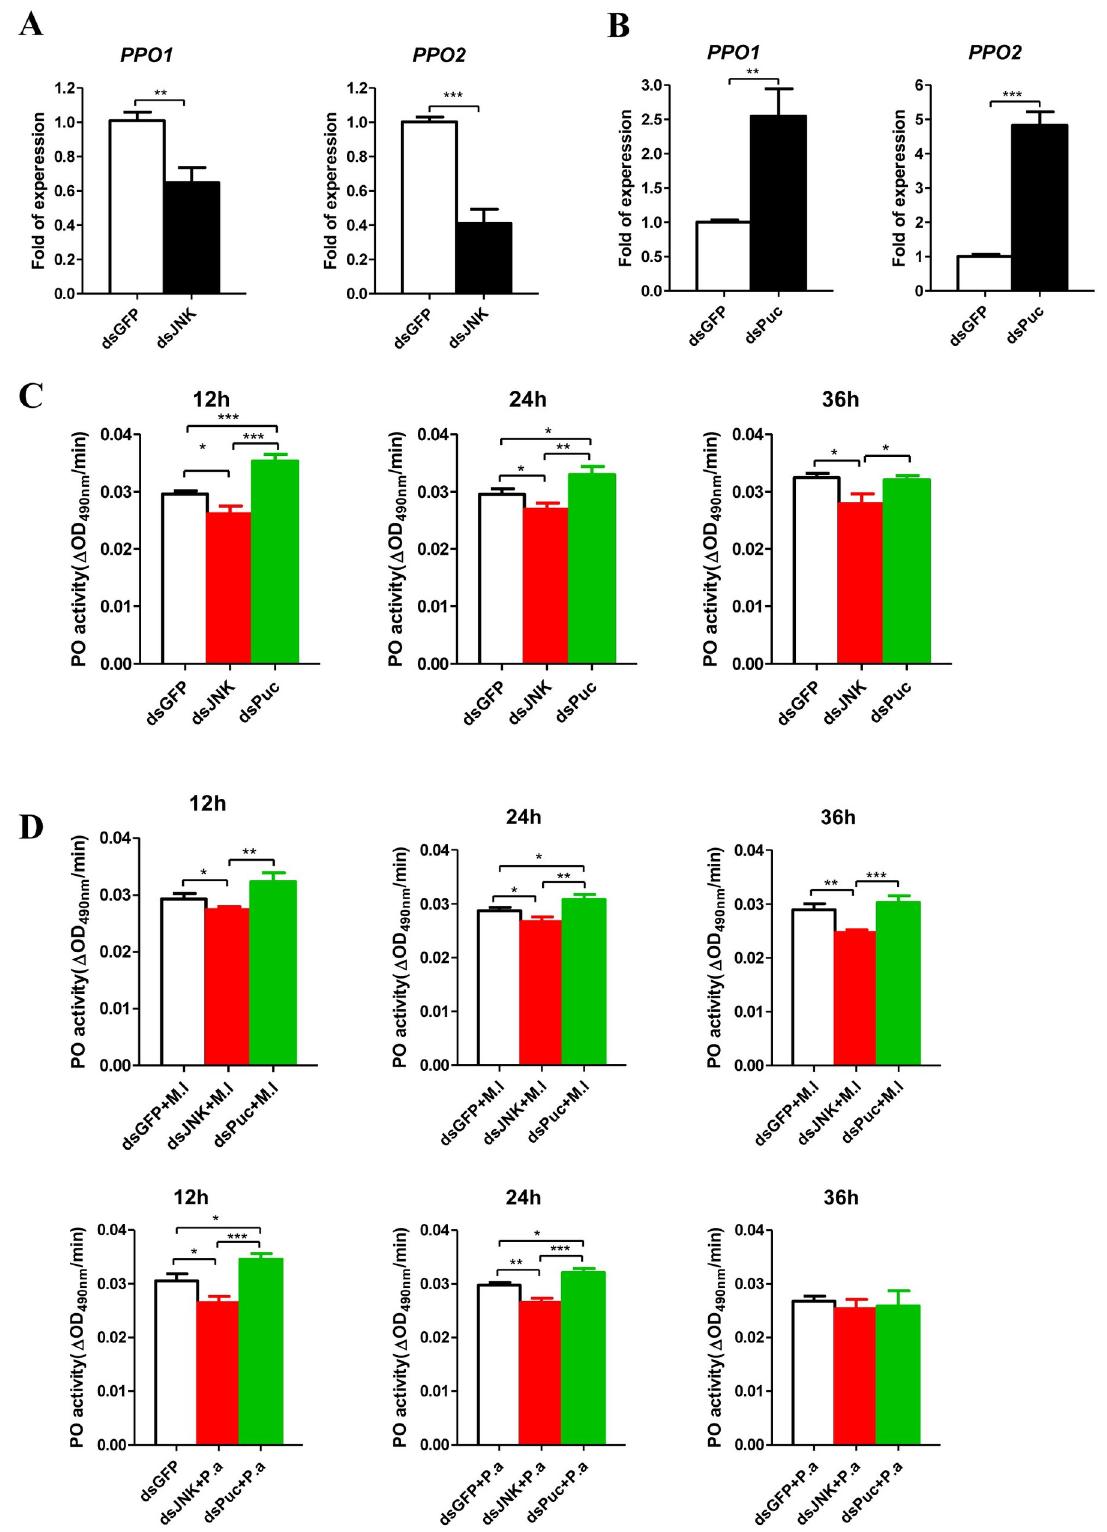
Fig 3. JNK pathway regulates PPOs expression and PO activity. Effect of JNK (A) and Puc (B) silence on the expression of PPO1 and PPO2 of pea aphids. The expressions of PPO1 and PPO2 were normalized with rpl7 of the pea aphids. The statistical differences between